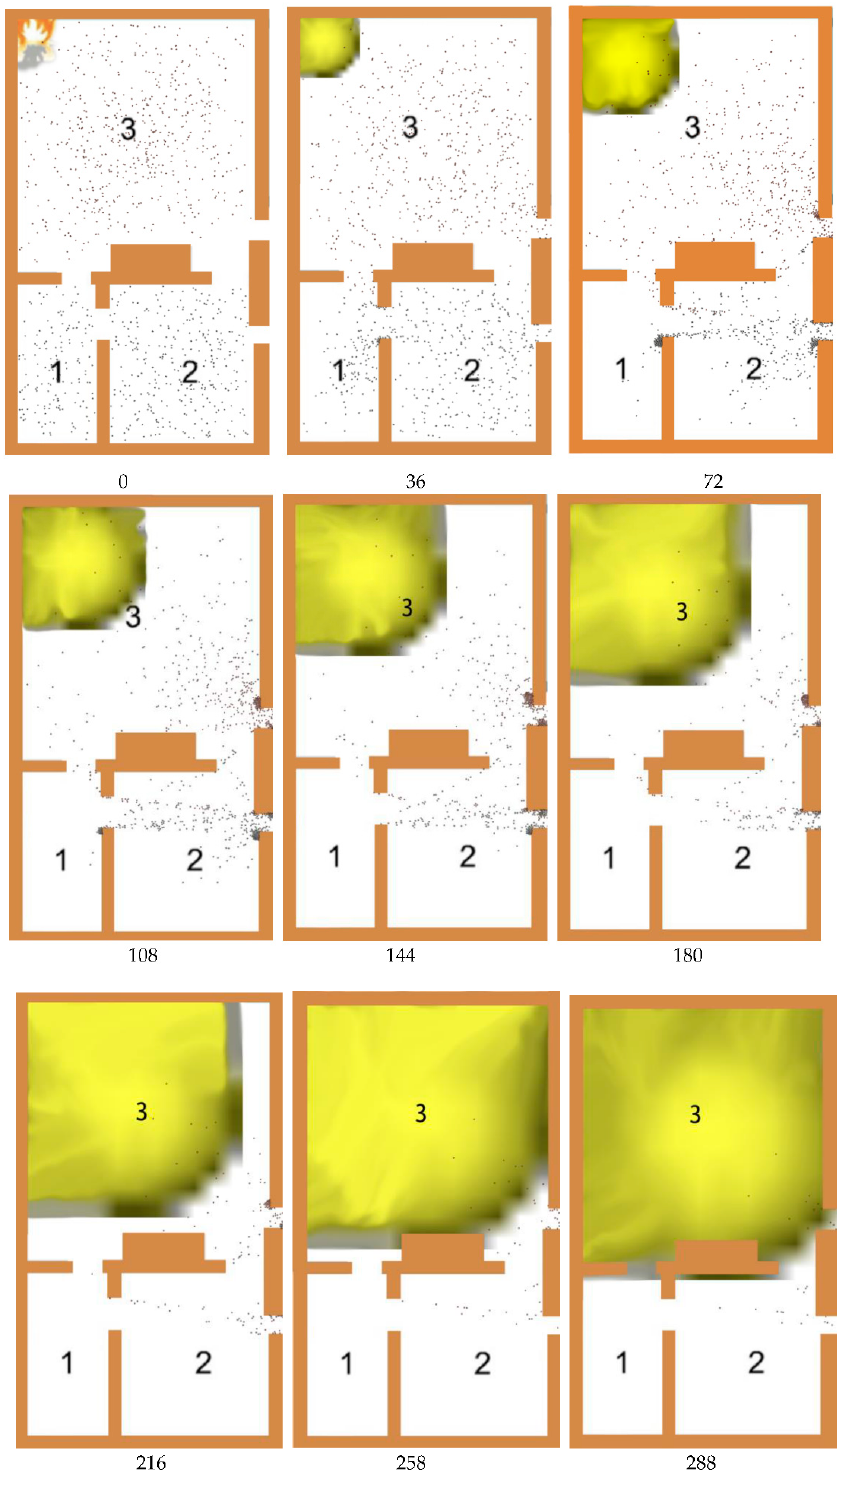
Figure 4. Escape Opportunity Choice in Main Time (Unit: s).